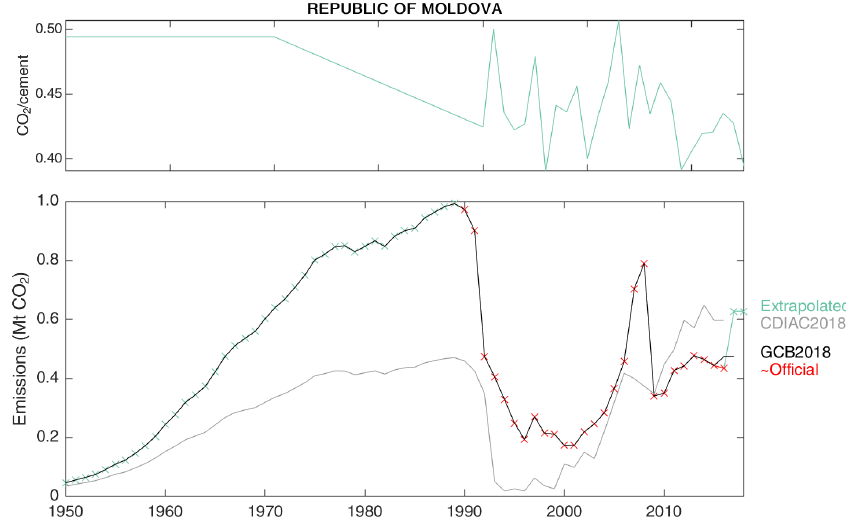
Figure C31. Revised cement emissions for Moldova.